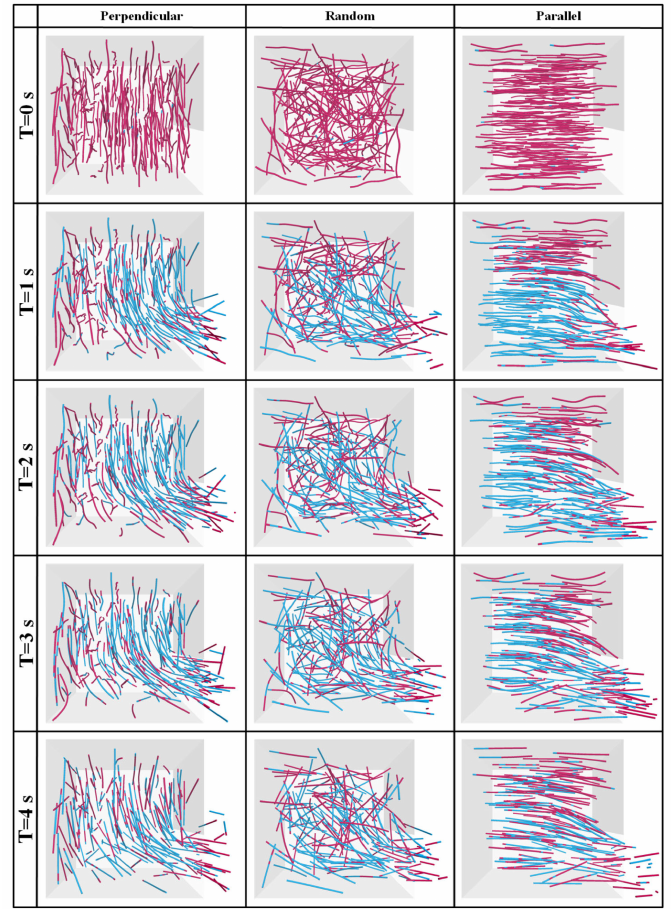
Figure 17. The spatial distribution of the tensile and compressive forces with time (the sand particles are not